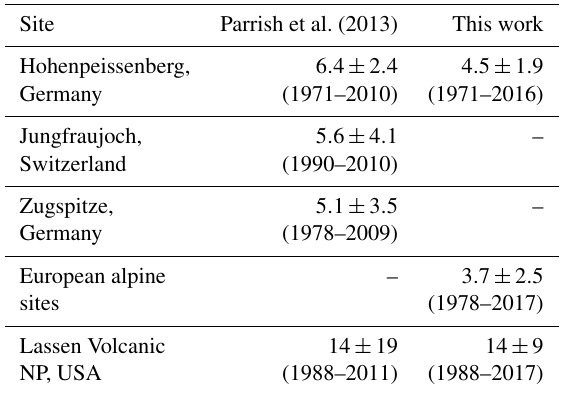
Table 2. Linear fits to shifts in the phase of the ozone seasonal cycle analysis; units are days per